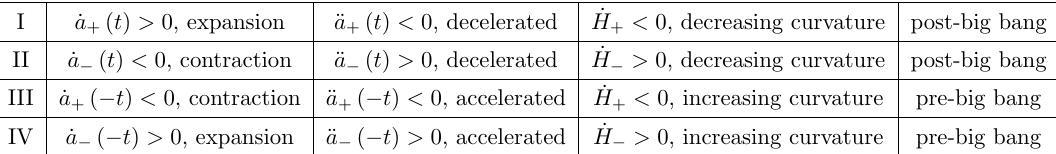
Table 1 . The properties of the string cosmological solutions at the leading